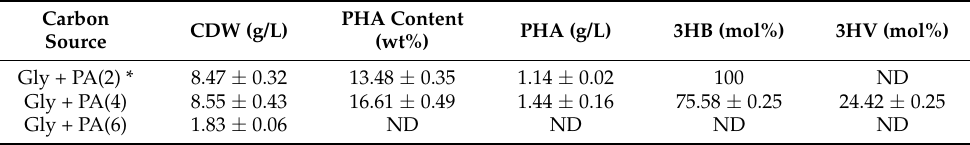
Table 3. Production of PHBV by V. alginolyticus LHF01 using glycerol and propionate.